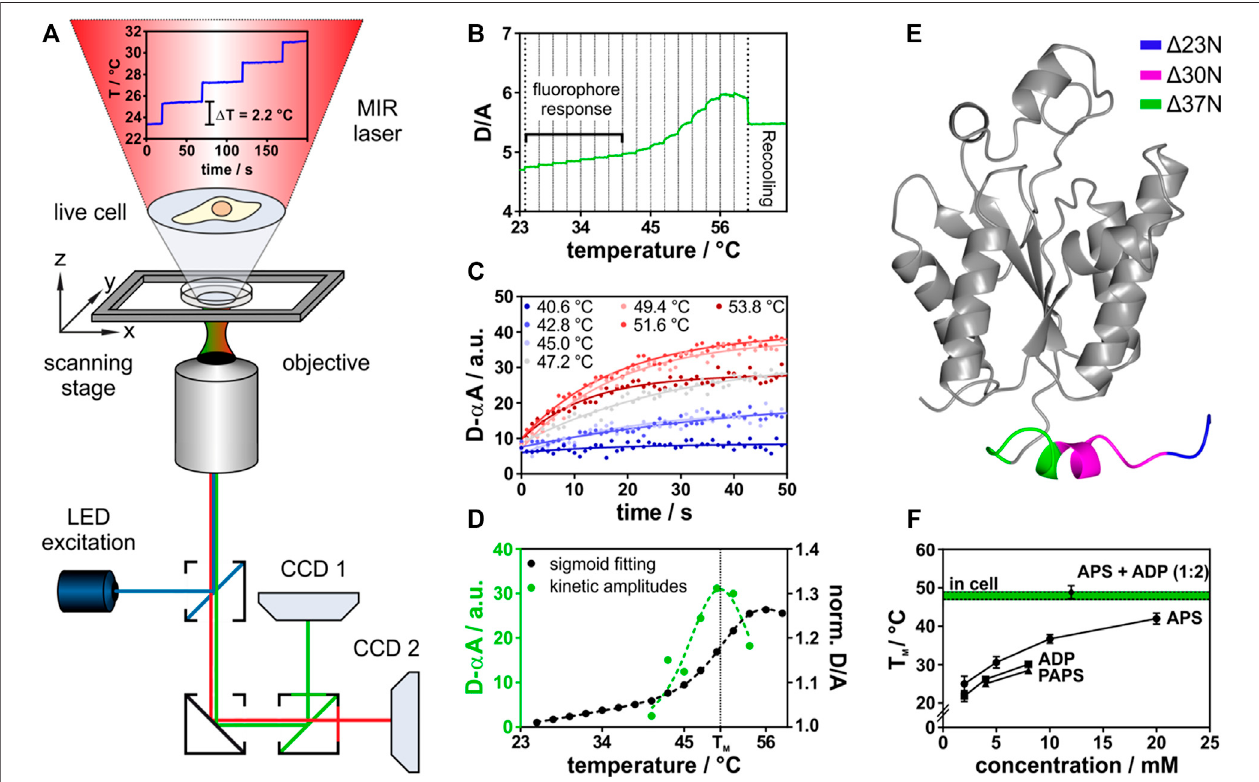
FIGURE 1 | In-cell thermal unfolding of APSK37 using Fast Relaxation Imaging. (A) Representation of the Fast Relaxation Imaging setup. (B) Thermal unfolding curve of APSK37. Bold dotted lines represent start and end-point of T-jumps applied. Faint dotted lines represent start-point of each single T-jump. (C) Kinetics of APSK37 unfolding at the respective temperatures. (D) Comparison of sigmoid fi tting of the thermal unfolding data to the Better Thermodynamics from Kinetics method. (E) CrystalstructureofhumanPAPSsynthase2APSkinasedomain (PDB:2AX4).TruncationsoftheN-terminaltailregionarehighlightedincolor. (F) Invitro ligand titrationofAPSK37(10 µM).TotalconcentrationofbothnucleotidesAPSandADPisattheindicated1:2ratio(8 mMADP,4 mMAPS).Datapointsrepresentmean ± s.d and include at least three replicates (N ≥ 3). For comparison, the APSK37 in-cell melting temperature is shown in green. Dotted lines indicate ± s.d. of